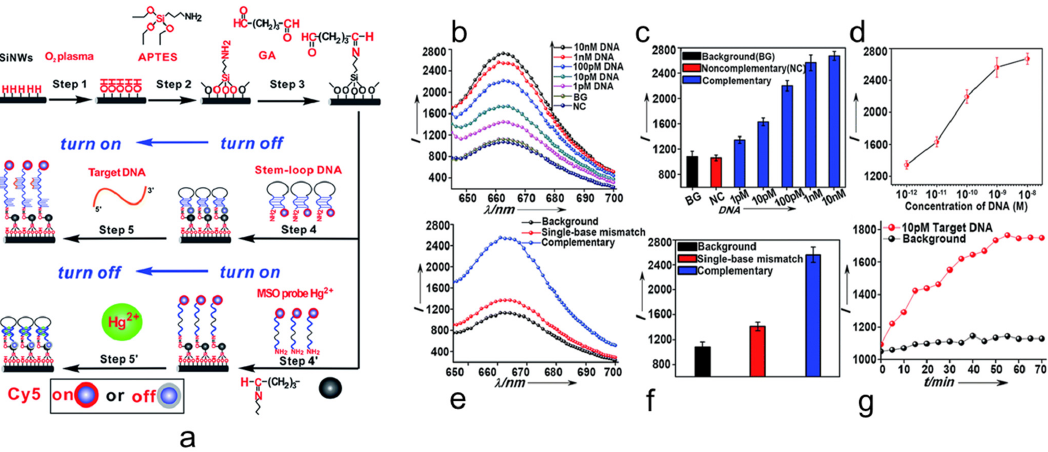
Figure 3. ( a ) Schematic representation of the functionalization steps and working principle of the Si NW nanoMB sensor for DNA and Hg 2+ detection [97]. ( b ) PL spectra obtained at different DNA target concentrations, background (BG), and non-complementary DNA (NC) [97]. ( c ) PL integrated signal for the different concentrations of DNA target, background, and non-complementary DNA [97]. ( d ) Dose-response curve obtained as the integrated PL signal as a function of the DNA concentration for the complementary DNA. [97] ( e ) PL spectra reporting the comparison between complementary DNA and single-base mismatch DNA signal [97]. ( f ) Integrated PL reporting the clear difference between complementary target and single-base mismatch DNA [97]. ( g ) Kinetic of the fluorescence restoring as a function of the conformational change of